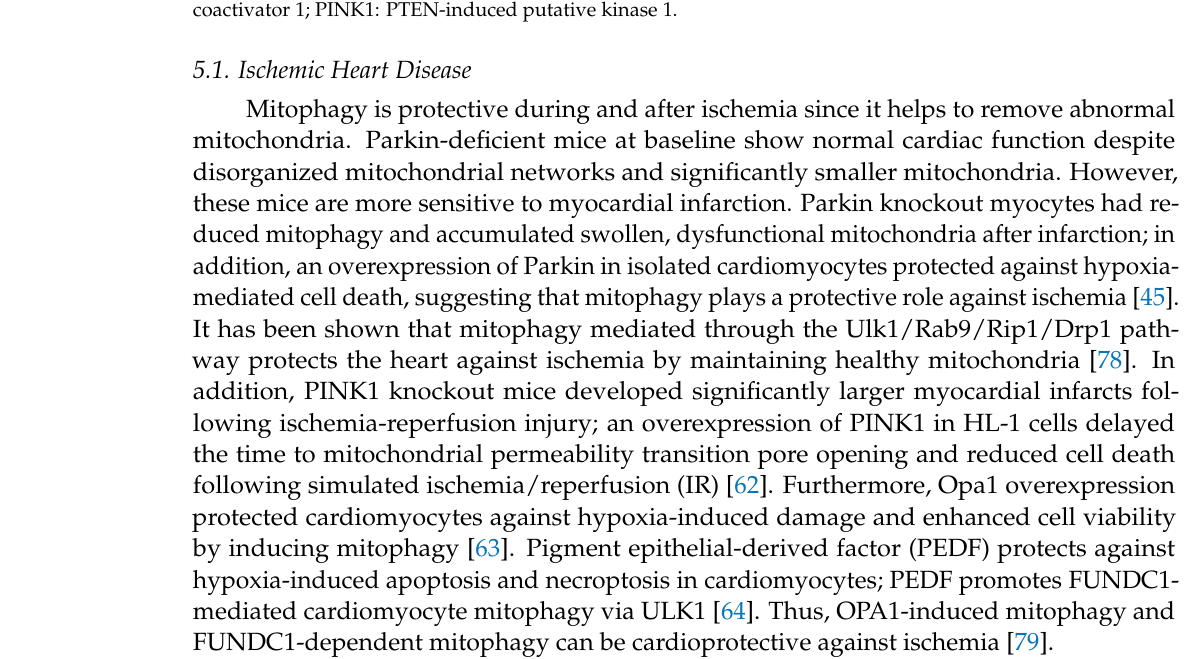
Table 1. Mitochondria Quality Control Alterations in Cardiovascular Diseases.